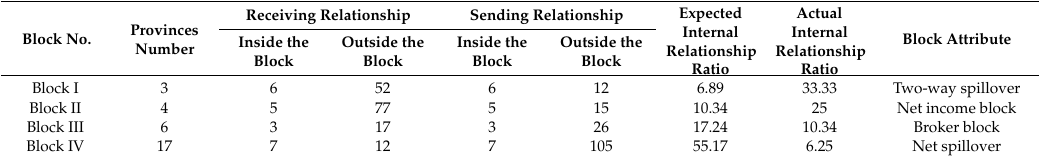
Table 8. The spillover e ff ects of spatial associations of the ANTCE